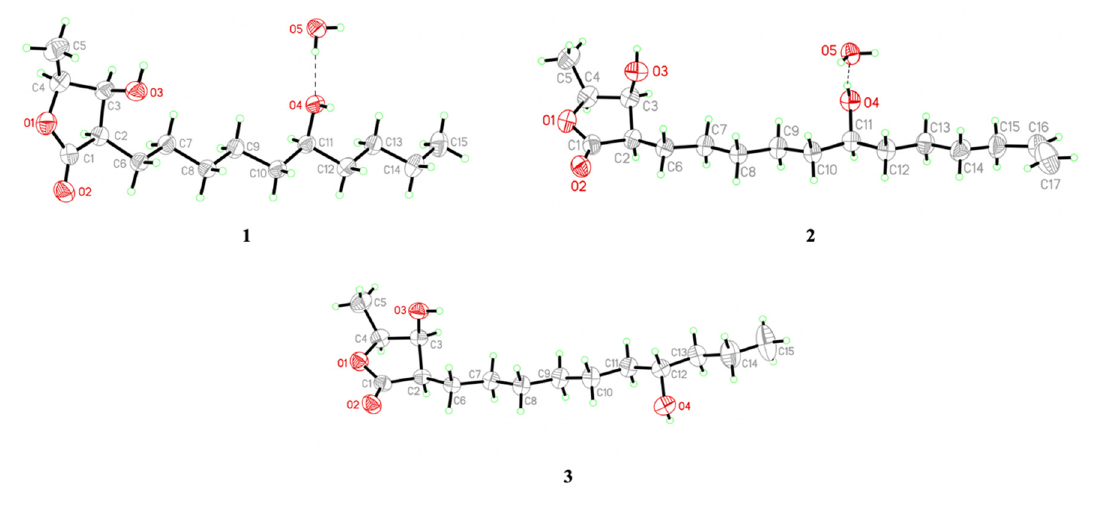
Figure 4. Perspective drawing of X-ray structures of machinolides A–C ( 1 – 3 ).